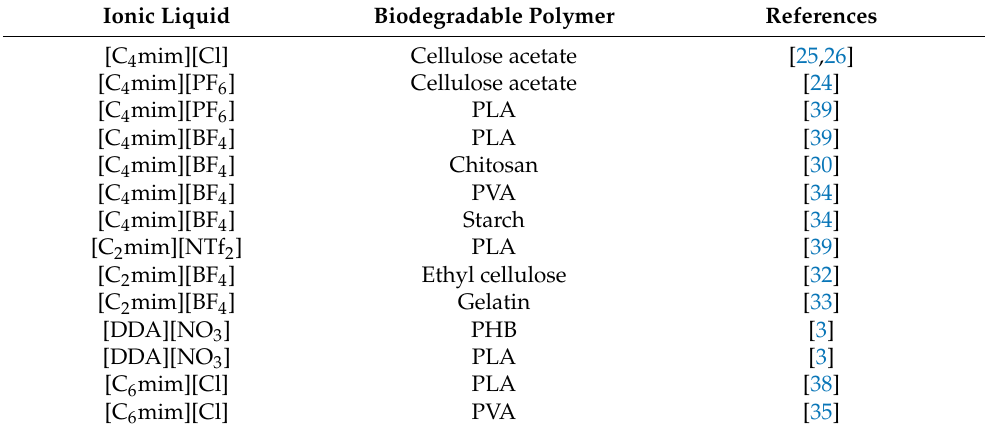
Table 4. Examples of ionic liquids utilized as additives for electrospinning of biodegradable polymers. Ionic